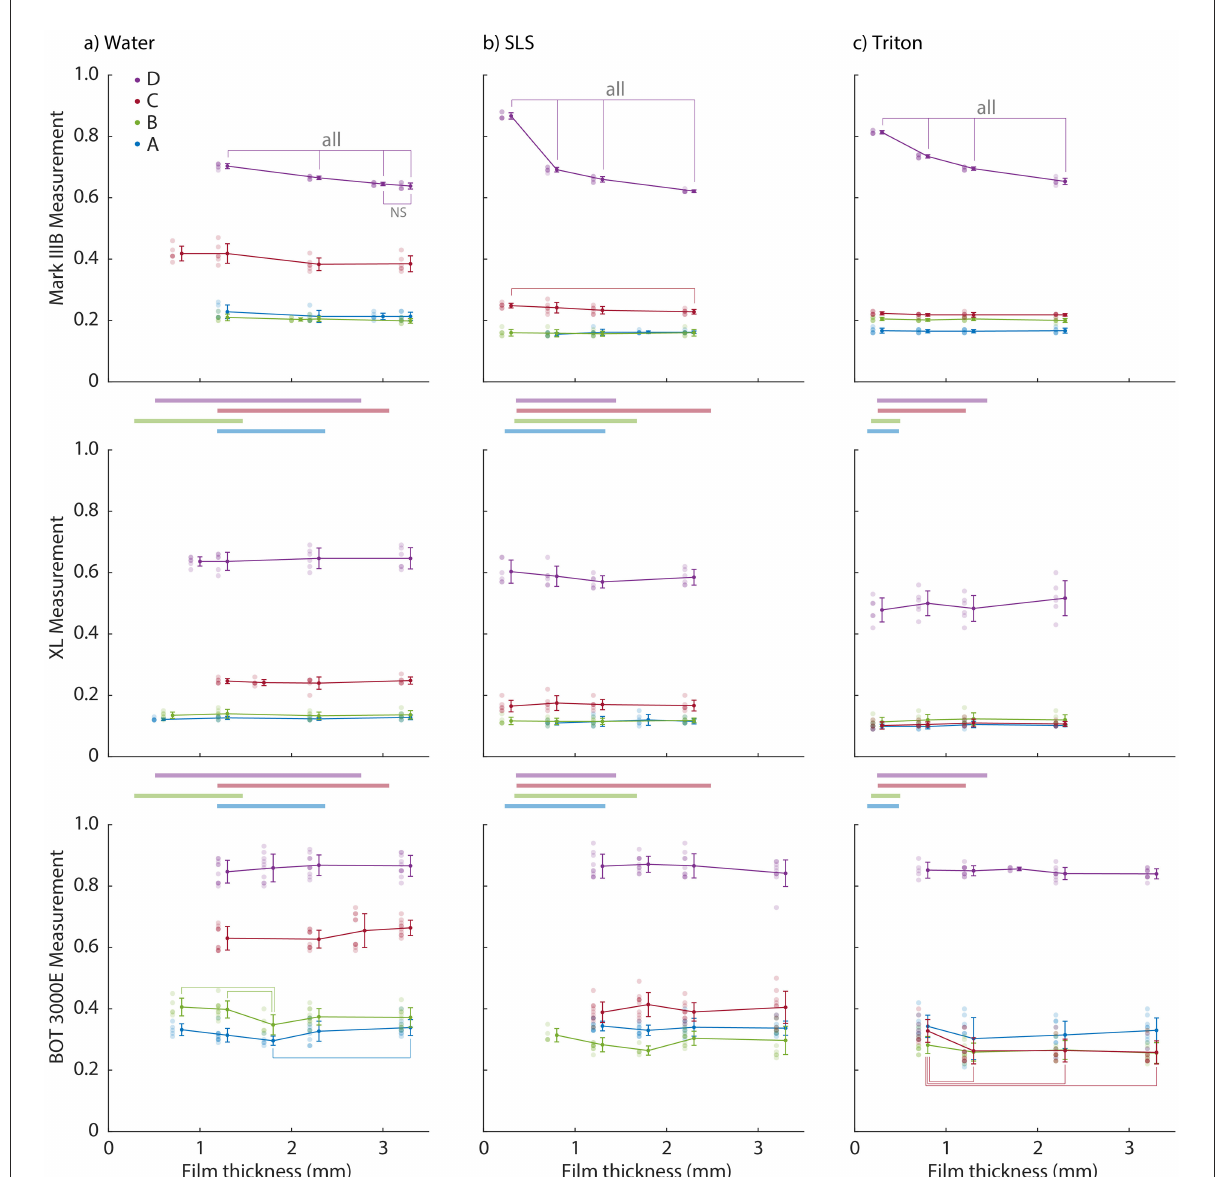
FIGURE4 Raw data and mean ± SD of the friction measurements as a function of film thickness for the four reference surfaces (colored lines within each graph), three tribometer models (rows of graphs) and three contaminants [columns of graphs: (a) water, (b) SLS, and (c) Triton]. Significant differences within each combination of tribometer, surface, and contaminant are highlighted using thin vertical and horizontal bars; “all” means that all connected comparisons are significantly different (unless otherwise noted). The thick horizontal bars between the rows of graphs show the range of natural film thicknesses for each combination of contaminant and surface (colors match the surfaces in the graphs).